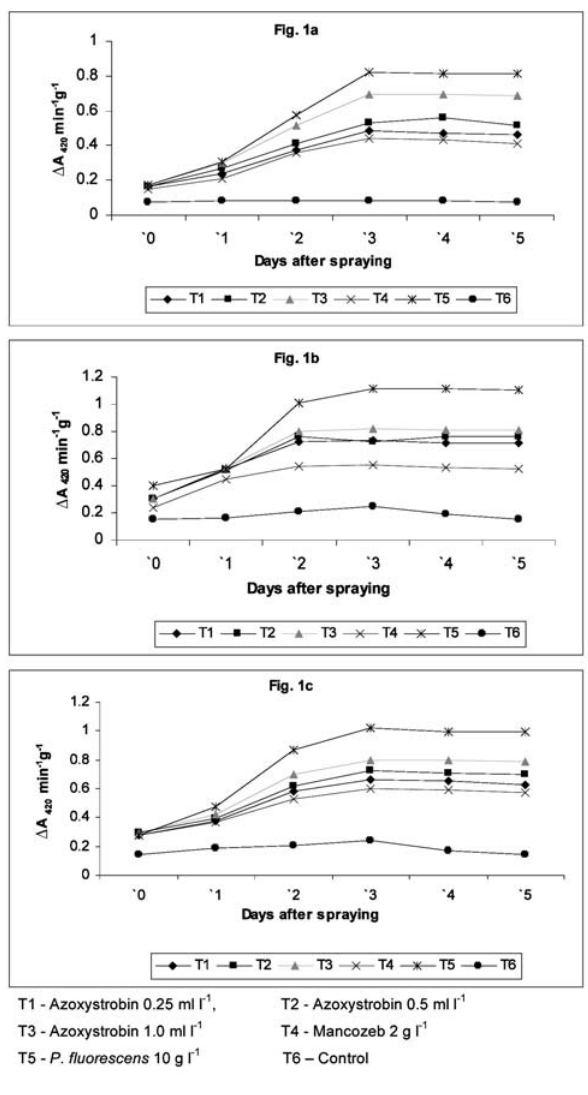
Fig. 1. Changes in PO activity in cucumber plants: 1a, uninoculated and treated with azoxystrobin and Pseudo- monas fl uorescens ; 1b, challenge-inoculation of downy mildew pathogen; 1c, challenge-inoculation of powdery mildew